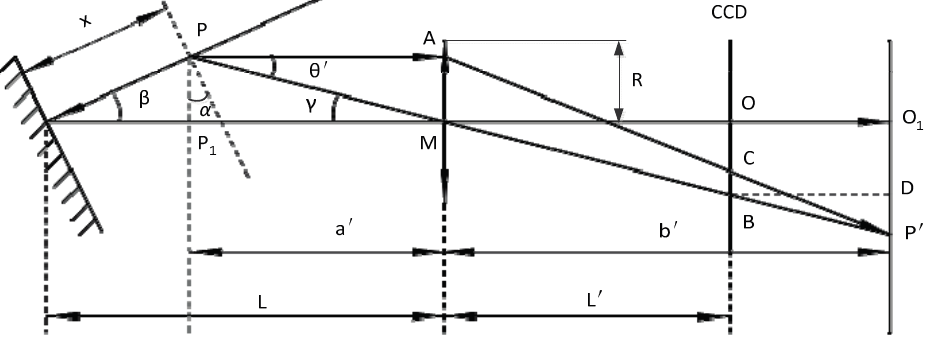
Figure 6. Schematic of the imaging performed by the receiving